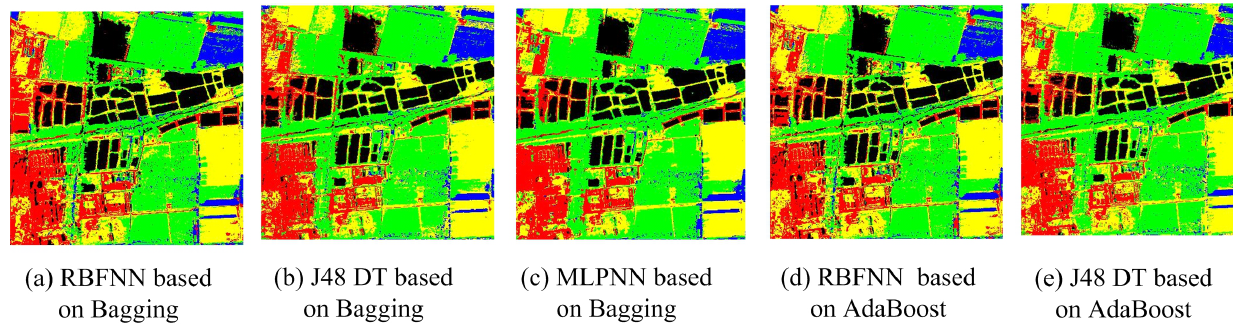
Figure 12. Classification result based on AdaBoost and Bagging.